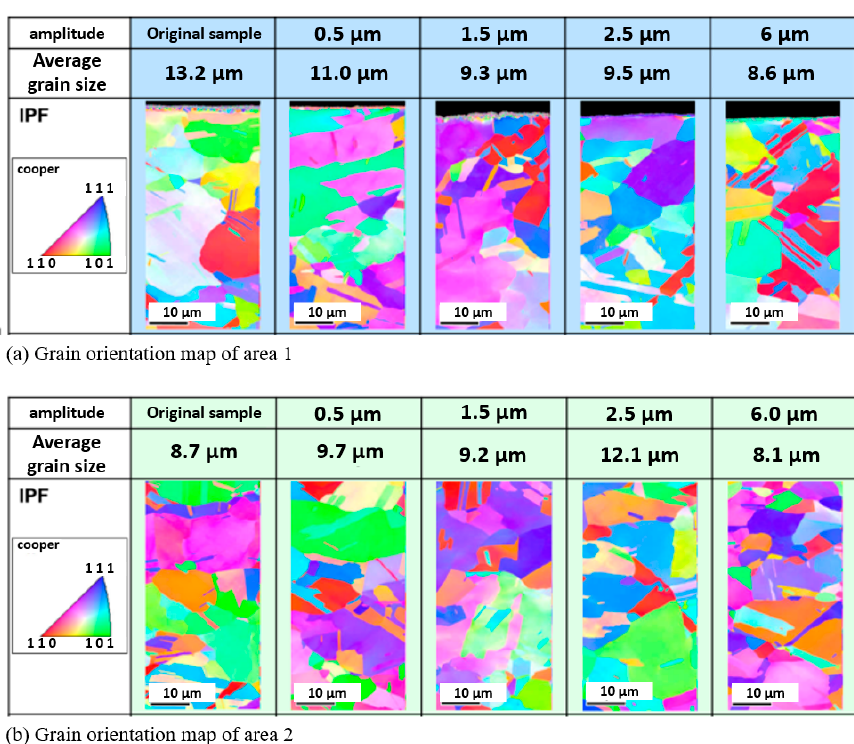
Figure 13. Result of the EBSD mapping in two areas.